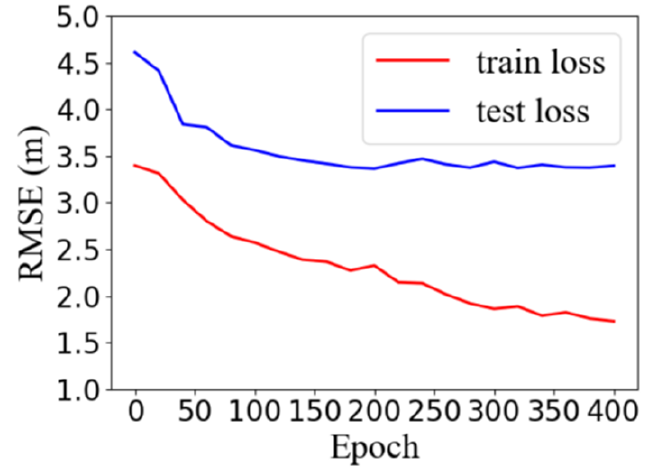
Figure 8. Train loss and test loss variation.